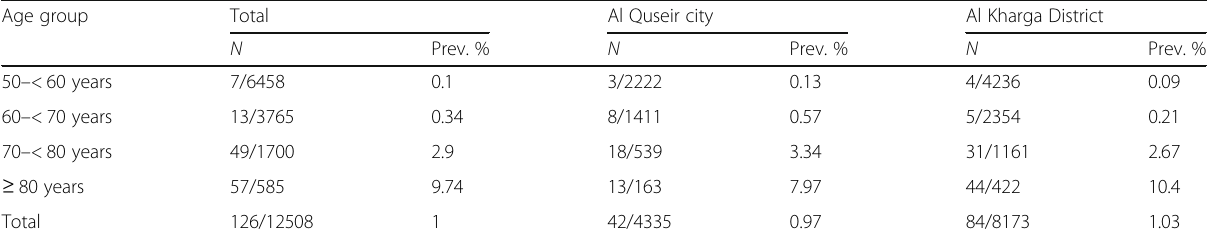
Table 1 Age-specific prevalence of Alzheimer ’ s dementia in upper Egypt, Desert area (Al Kharga and Al Quseir)